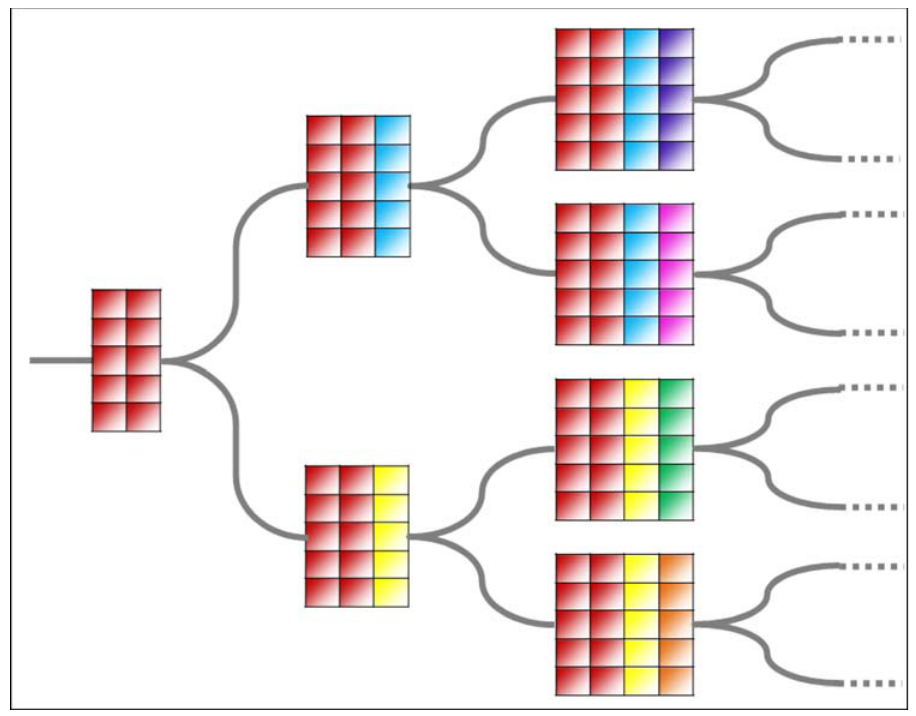
Figure 9. Simulating the evolutionary process forward through time. Similar colors denote shared regulatory wiring.